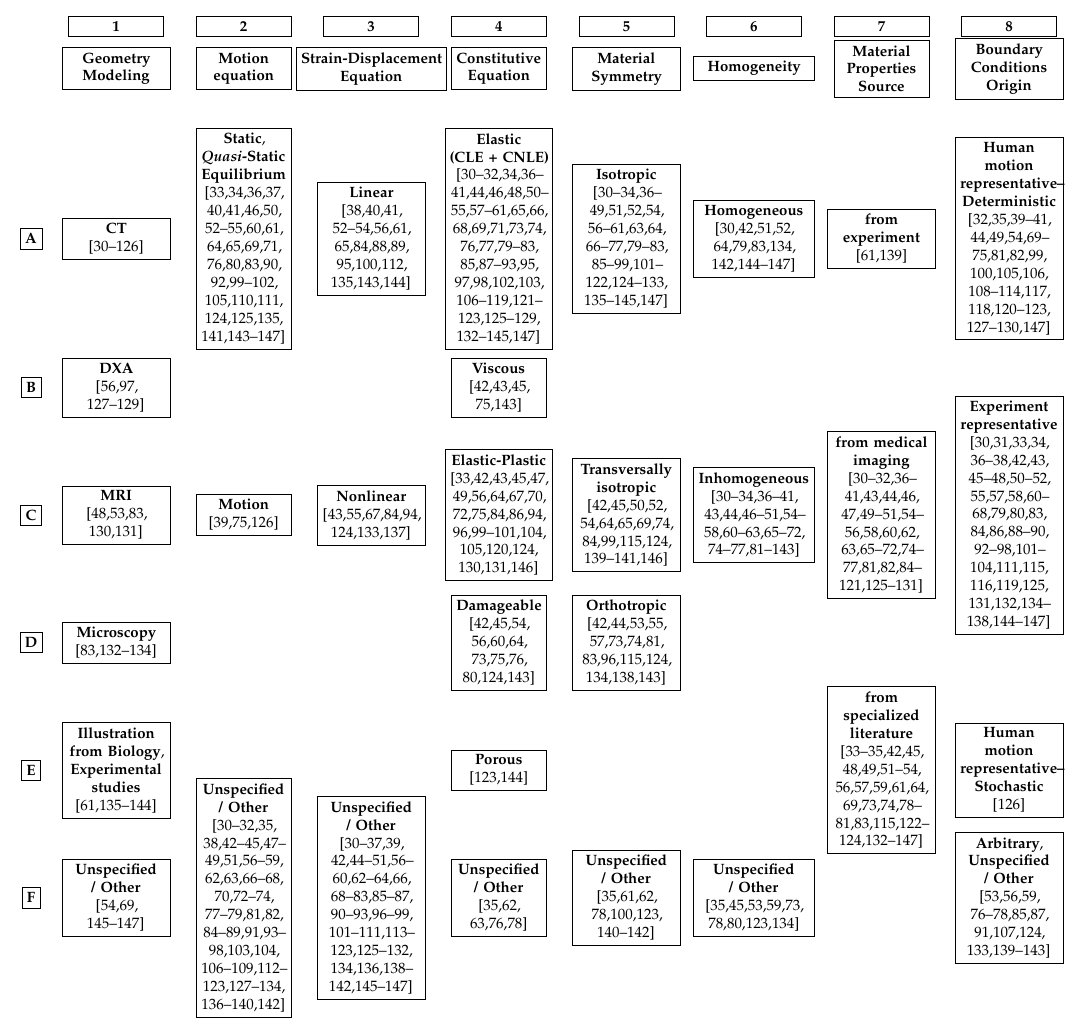
Table 2. Categorization of surveyed literature that modelled bone as a solid continuum [30–147].